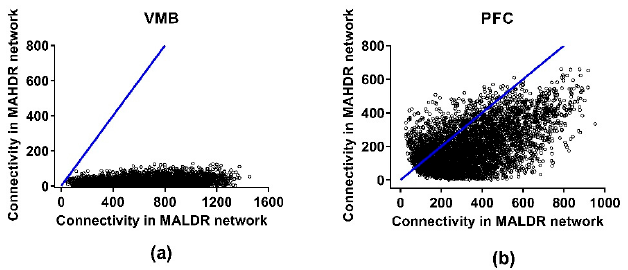
Figure 5. Effects of selection on total network connectivity for the cosplicing networks in the methamphetamine high drinking (MAHDR) and methamphetamine low drinking (MALDR) selected lines. Connectivity is shown in ( a ) for the ventral midbrain (VMB) and ( b ) for the prefrontal